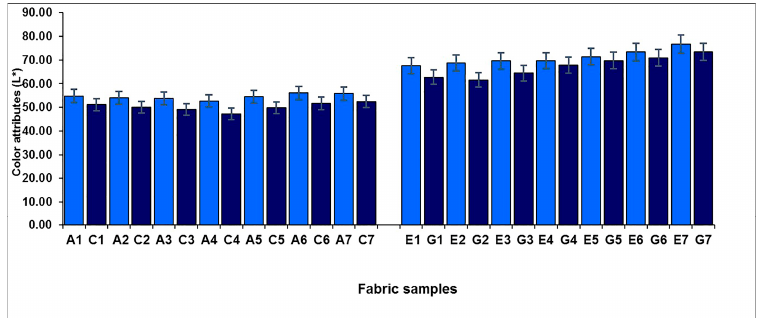
Figure 6. Effect of weft-backed structure on the lightness of blue-red and yellow-green mixed